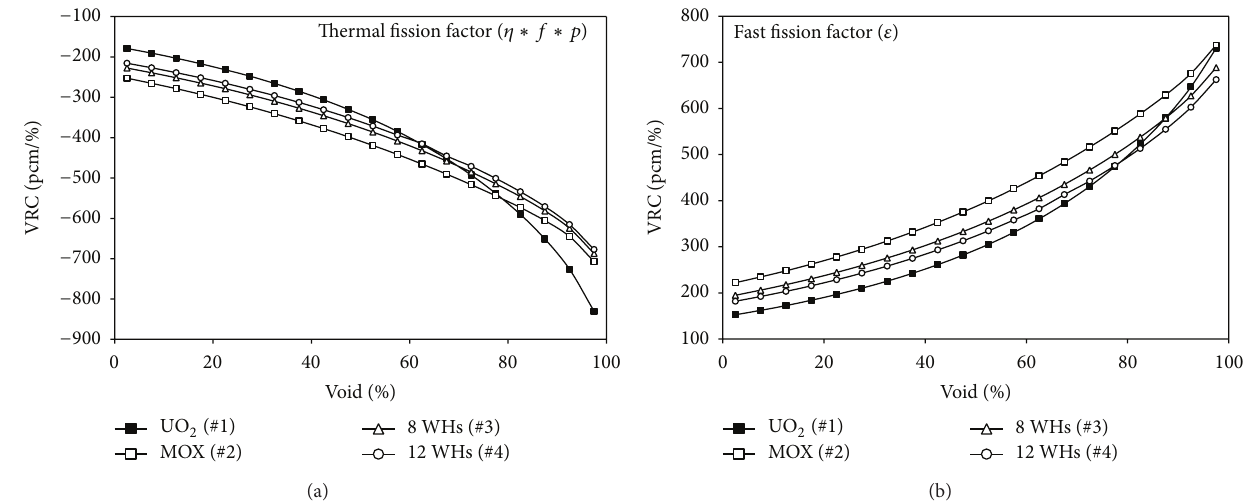
Figure 10: Values of void reactivity coefficients for thermal and fast fission factors.